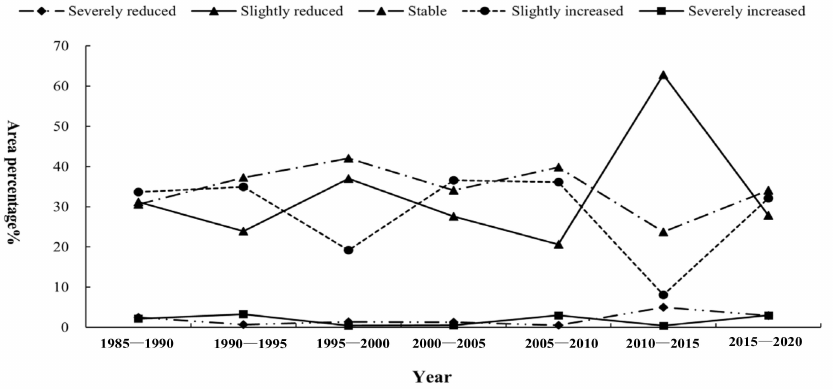
Figure 7. Percentage of rocky desertification change area in different historical